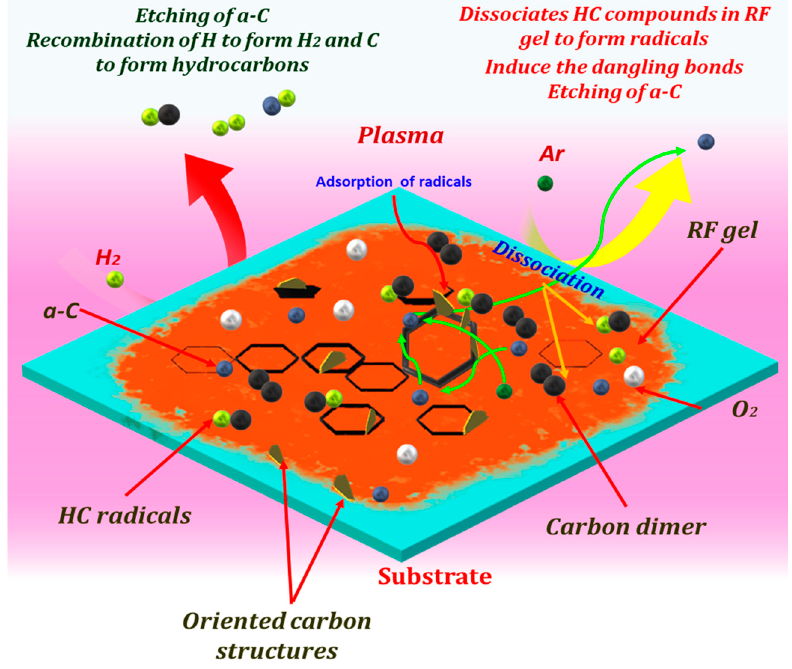
Figure 6. Schematic of the possible mechanism of the growth of OCNs by the plasma reformation of RF gel at the plasma discharge conditions power of 250 W, time of 8 min, and the flow rate of 100:50 sccm.